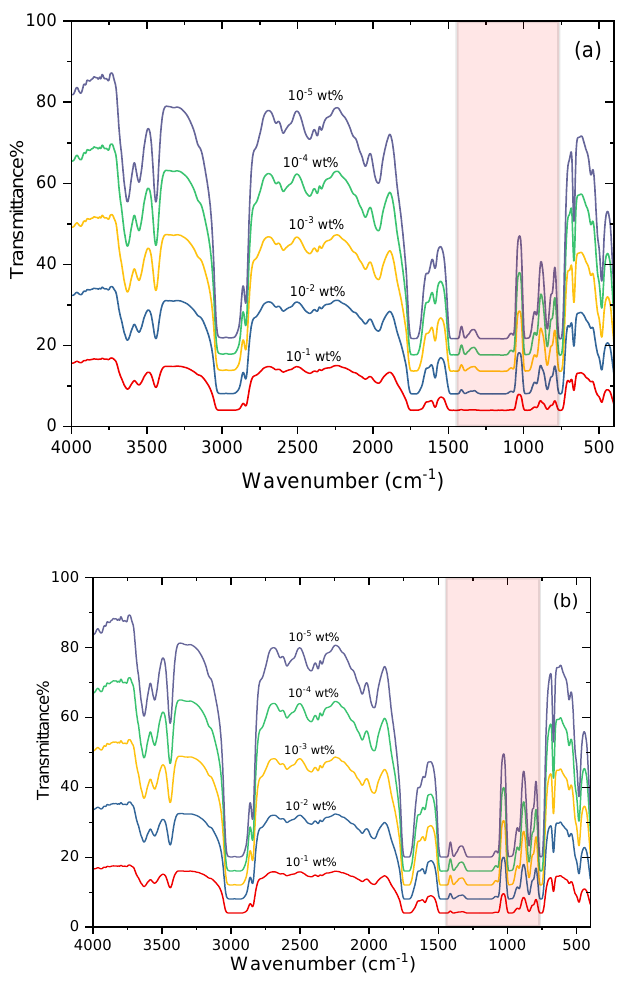
Figure 8. FT-IR transmission spectra for photoselective PMMA greenhouse films doped with perylene dyes ( a ) KREMER 94720 and ( b ) KREMER 94739; the shaded pink area represents the range 7 – 13 µm for calculating the infrared efficiency.